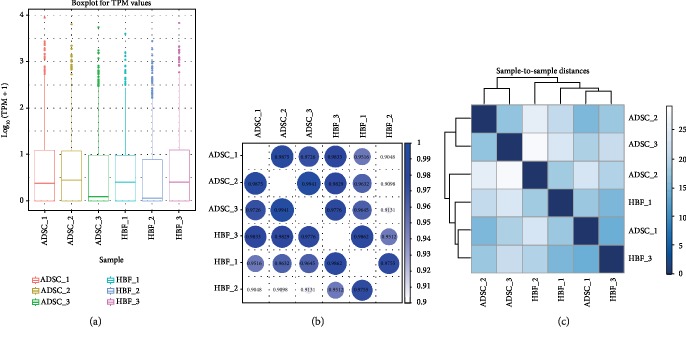
The analysis of miRNA expression. (a) Box line graph of miRNA expression in each sample. (b and c) Correlation coefficient thermogram and sample-to-sample cluster analysis in each sample.